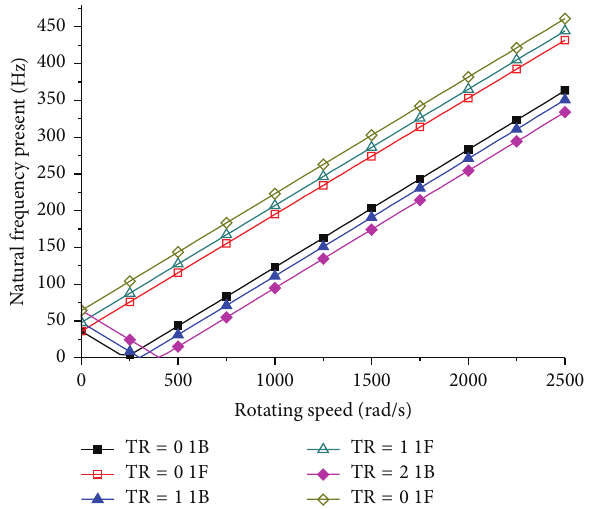
Figure 13: Campbell diagrams of the shaft with 𝜃 = 60 ∘ .